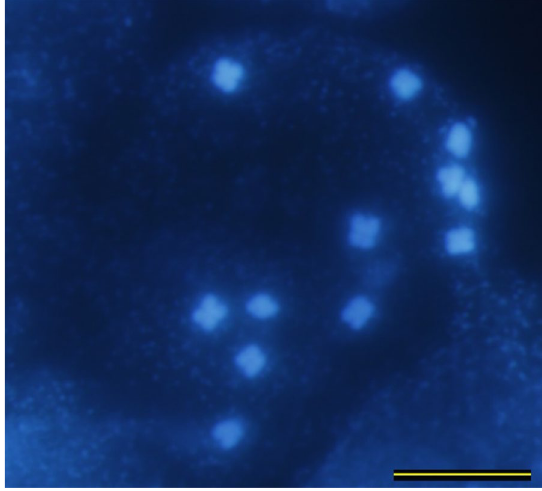
Fig. 5 Mitotic metaphase of Plantago maxima after staining with (DAPI) (2 n 2 x 12.). Scale bar = =